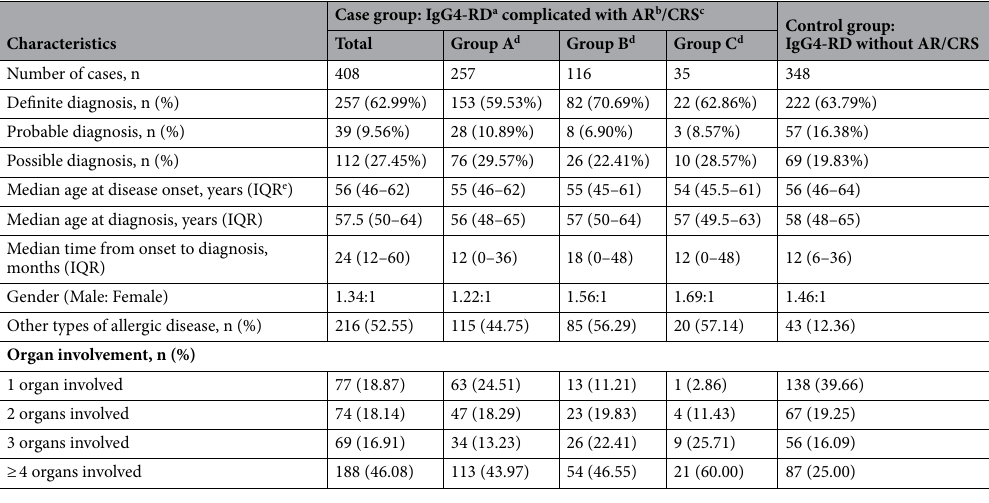
Table 1. Demographic and clinical characteristics of 756 IgG4-RD patients. a IgG4-RD, IgG4-related disease; b AR, allergic rhinitis; c CRS, chronic rhinosinusitis; d Group A included IgG4-RD patients complicated with AR, Group B included IgG4-RD patients complicated with CRS and Group C included IgG4-RD patients complicated with AR and CRS; e IQR, interquartile